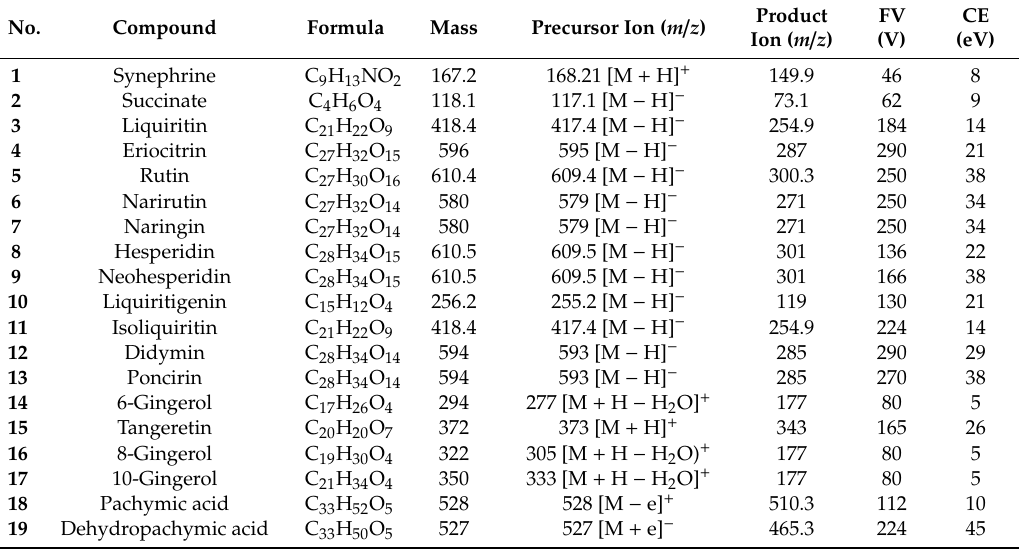
Table 1. Chemical formulas, masses, precursor ions, product ions, FVs and CEs of the 19 chemicals.